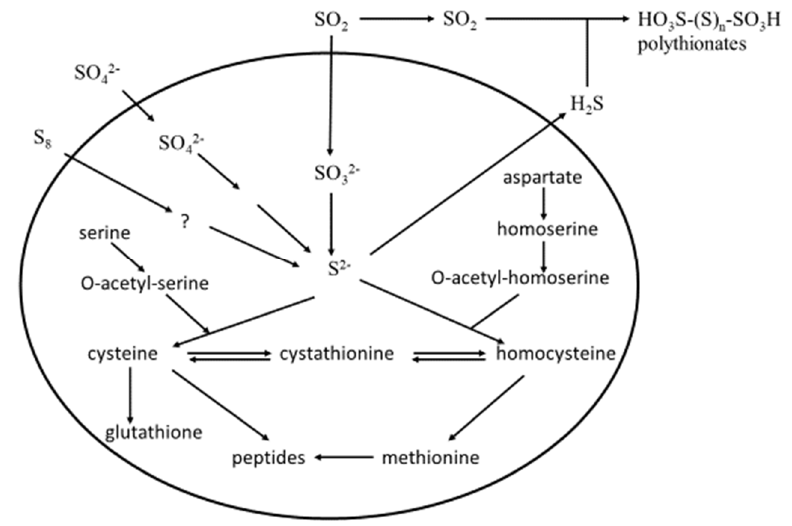
Figure 2. Sulfate assimilation pathway (SAP) in Saccharomyces cerevisiae. Top right: the formation of polythionates from the yeast metabolites H 2 S and SO 2 ([20], modified).